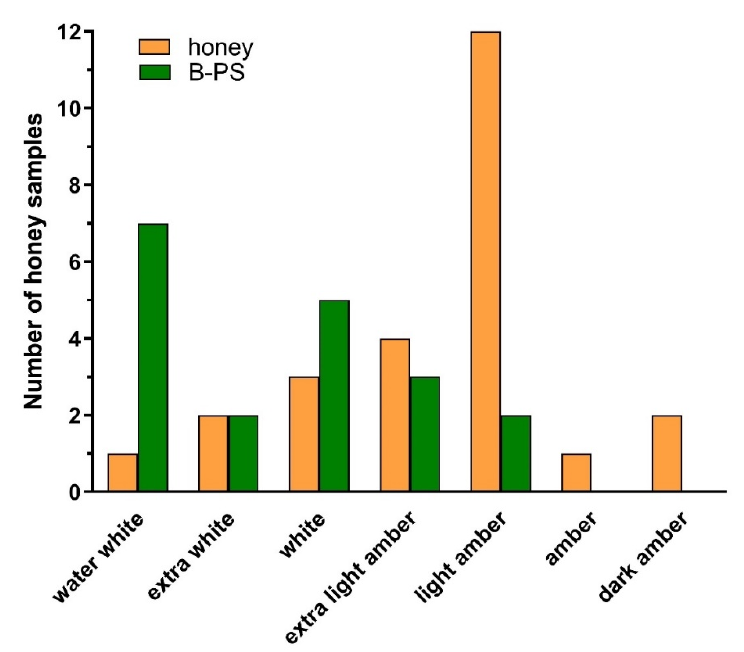
Figure 7. Color analysis of honey samples and bee-processed syrups. The color-grading system consisted of seven different colors (water white, extra white, white, extra light amber, light amber, amber and dark amber).